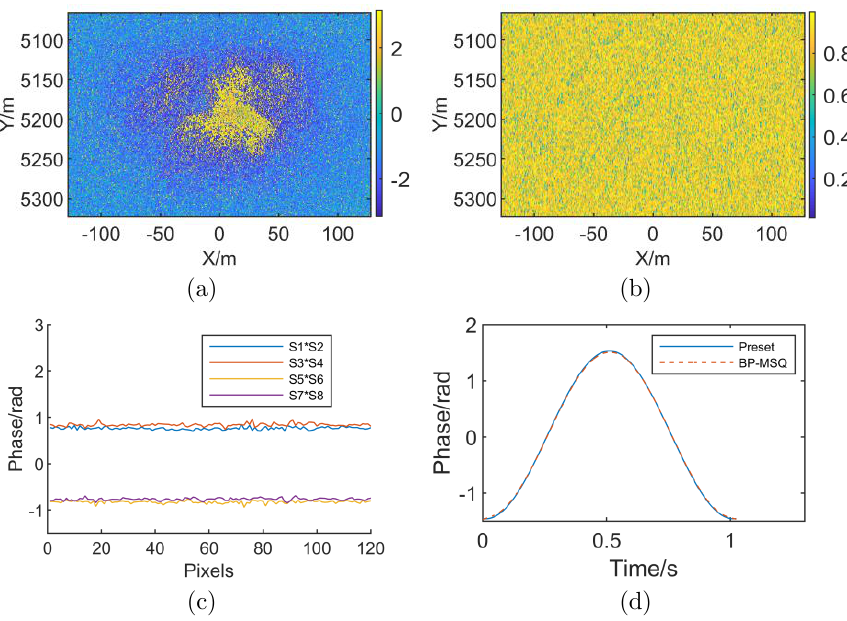
Figure 6. Spotlight SAR simulation results with high-order RME. ( a ) Interferometric phase with high-order RME ( b ) Coherence map with high-order RME ( c ) Subaperture differential interferometric phase ( d ) Comparison of preset value and estimation result of RME